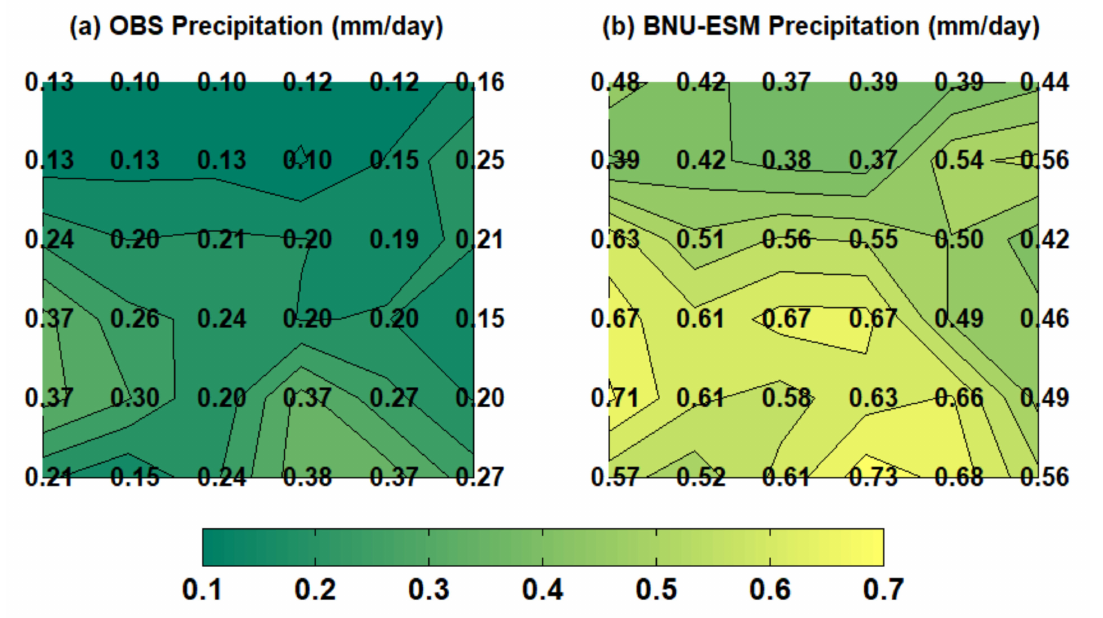
Figure 5. Mean daily precipitation (mm/day) for ( a ) OBS and ( b ) BNU-ESM in winter.